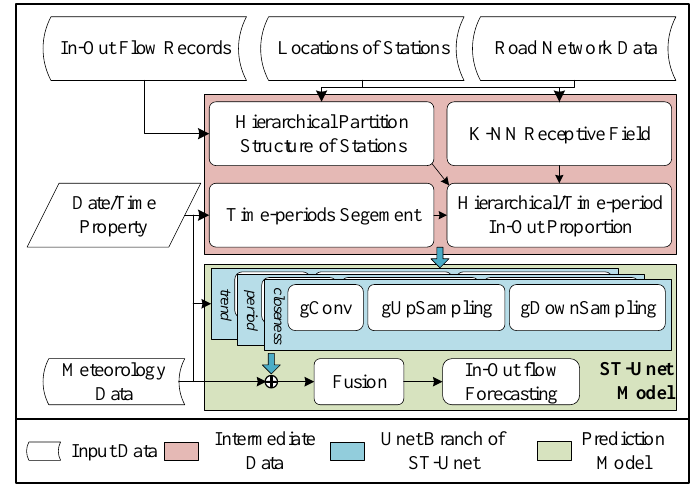
Figure 2. The framework of the forecast